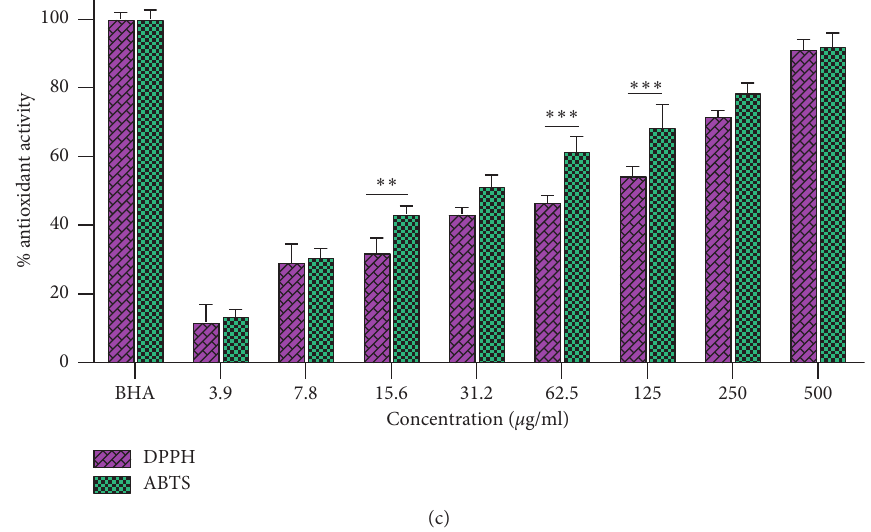
Figure 9: Inhibiting effect of ZnO-NPs on DPPH and ABTS radicals. (a) The nonlinear regression sigmoidal dose-response and logarithmic transformation of the ZnO-NP concentrations showed that EC 50 for ABTS and DPPH is log 1.498 and log 1.757, respectively. (b) Two-way ANOVA showed the significant difference between ABTS and DPPH tests at different concentrations of ZnO-NPs. (c) Dunn–ˇSid´ak comparison test indicated a significant difference compared to DPPH and ABTS radicals at the same concentration. ∗∗∗ p < 0 . 001; ∗∗ p < 0 . 01.